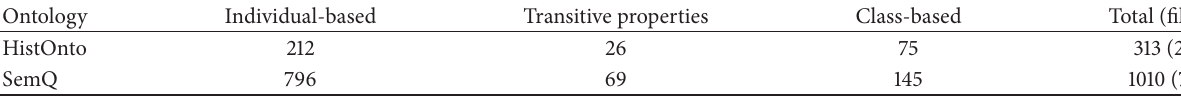
Table 3: Number of MCQ items generated.